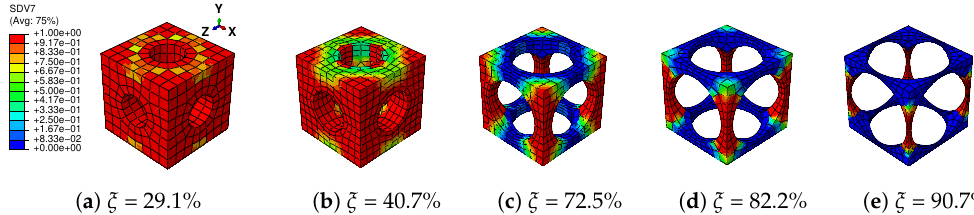
Figure 11. Distribution of martensitic volume fraction ¯ f t (named SDV7 in colorbar) on the RVEs with different void volume fractions ξ in compression loading at strain level − 10%.